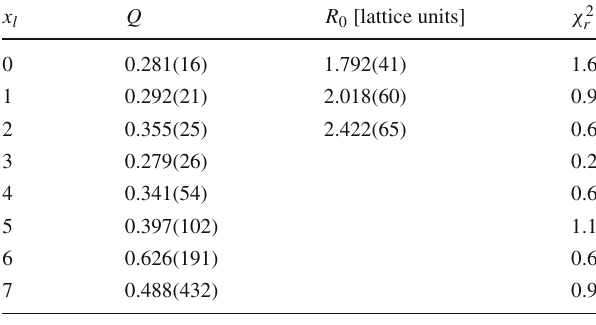
Table 4 Values of the fit parameters extracted from Coulomb fits of the E